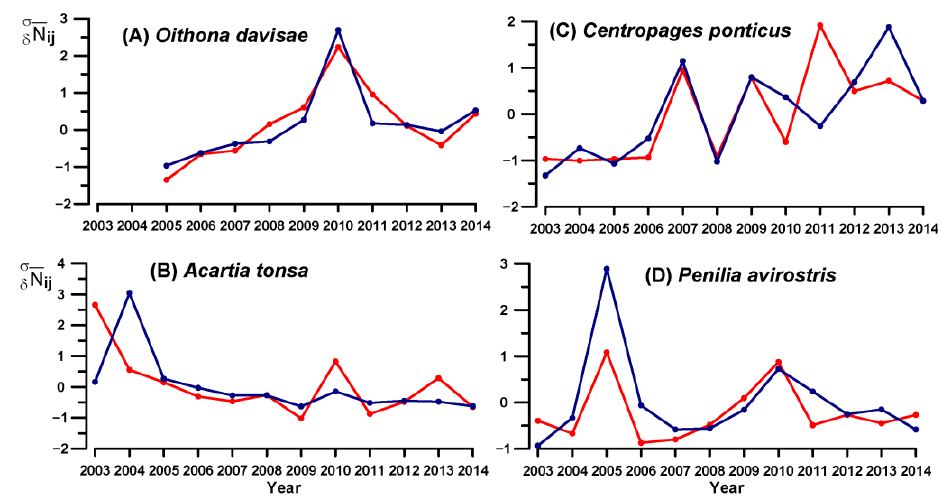
Figure 7. Pattern of interannual variability of abundance of the warm-water crustaceans in Sevastopol Bay at station 1 (blue) and station 2 (red) presented as normalized annual anomalies (see details of the method in Section 2.4): ( A )— Oithona davisae ; ( B )— Acartia tonsa ; ( C )— Centropages ponticus ; ( D )— Penilia avirostris .